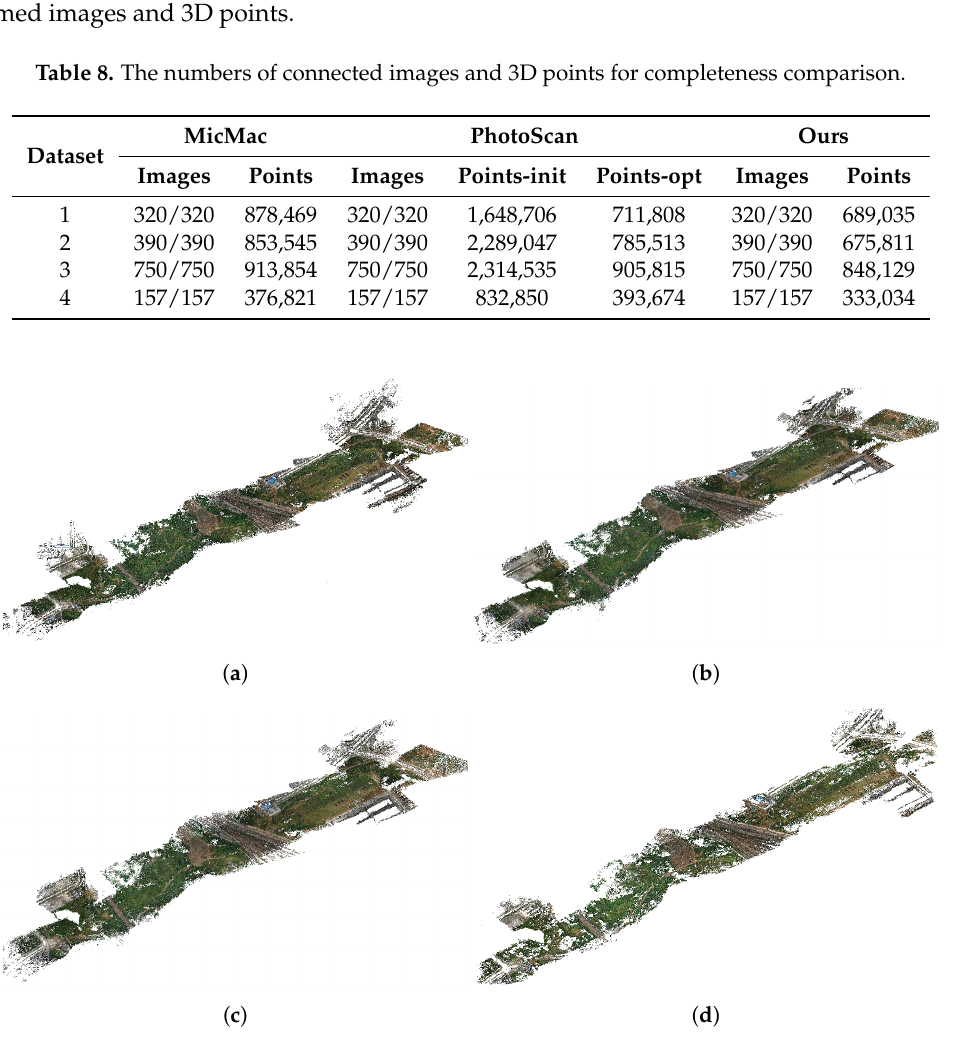
Figure 13. Reconstruction models of dataset 1: ( a ) MicMac; ( b ) PhotoScan-init; ( c ) PhotoScan-opt; ( d )